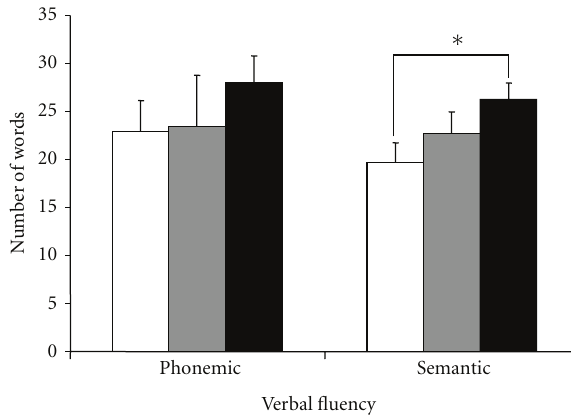
Figure 1: Phonemic and semantic verbal fluency mean results ( ± SEM) for participants with Parkinson’s disease with (white column) and without (grey column) depressive symptoms and healthy controls (black